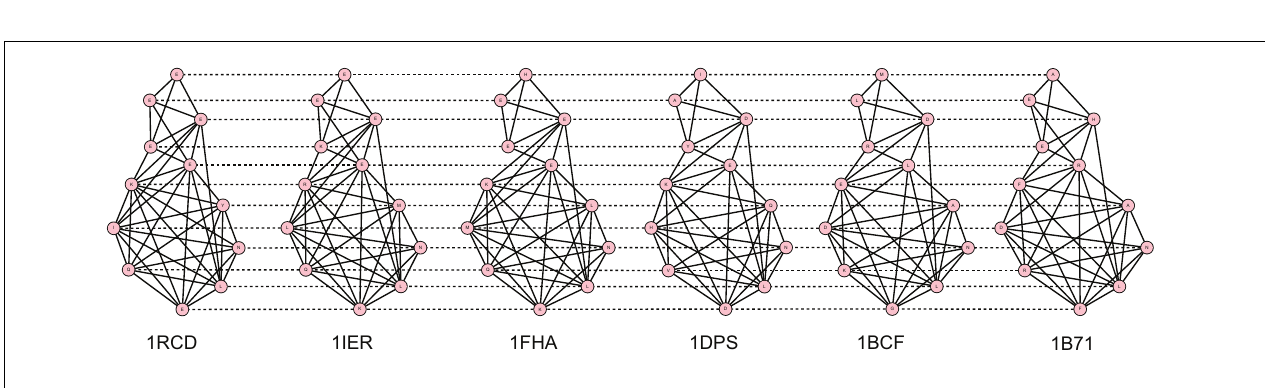
FIGURE 2 | Best alignment of the 8 Flavodoxin-like fold CheY-related contact maps with W = 10.